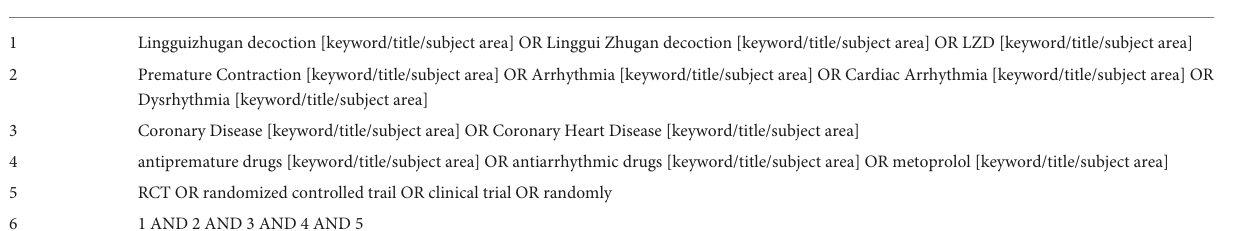
TABLE A7 Embase (Elsevier) search strategy.